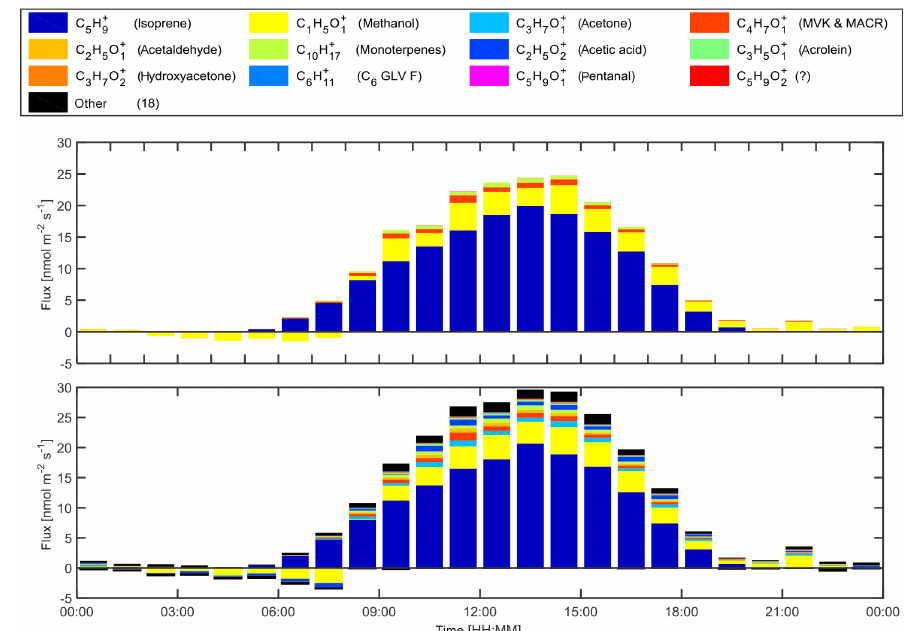
Figure 4. Diurnal flux plot of the manual method (top panel) and the automated method (bottom panel). For the automated method, the 10 σ noise compounds are plotted individually, while the remaining 18 compounds, which passed the 3 σ noise threshold (see Table A1), are summed up and plotted as “other”. All individual flux compounds are listed in Table